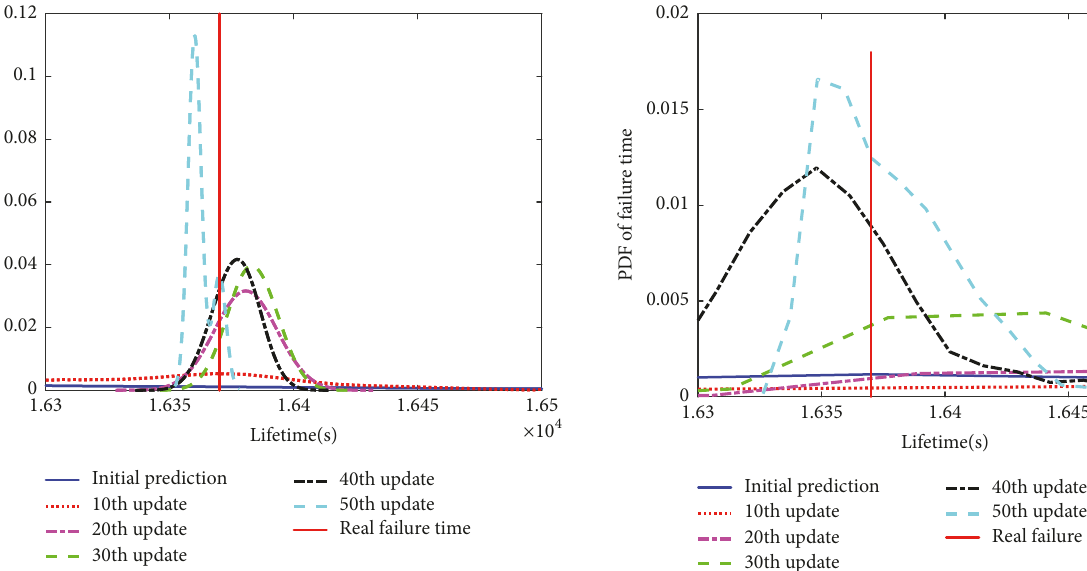
Figure 11: Updated failure time distribution of our model. Table 5: MAD of three methods at different time indexes. 𝑇 𝜁 Gebraeel’s model (s)